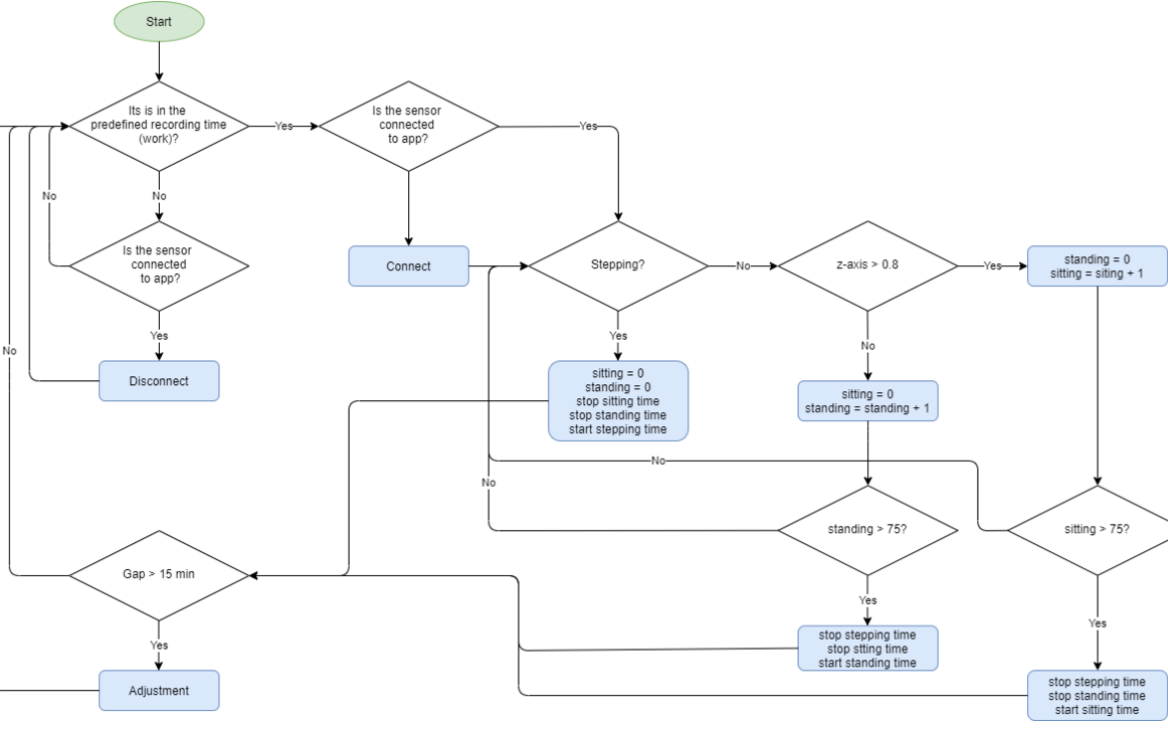
Figure 2. Flow diagram illustrating the algorithm for decision-rules used by the W@WApp + MetaWearC sensor to determine sitting, standing and stepping